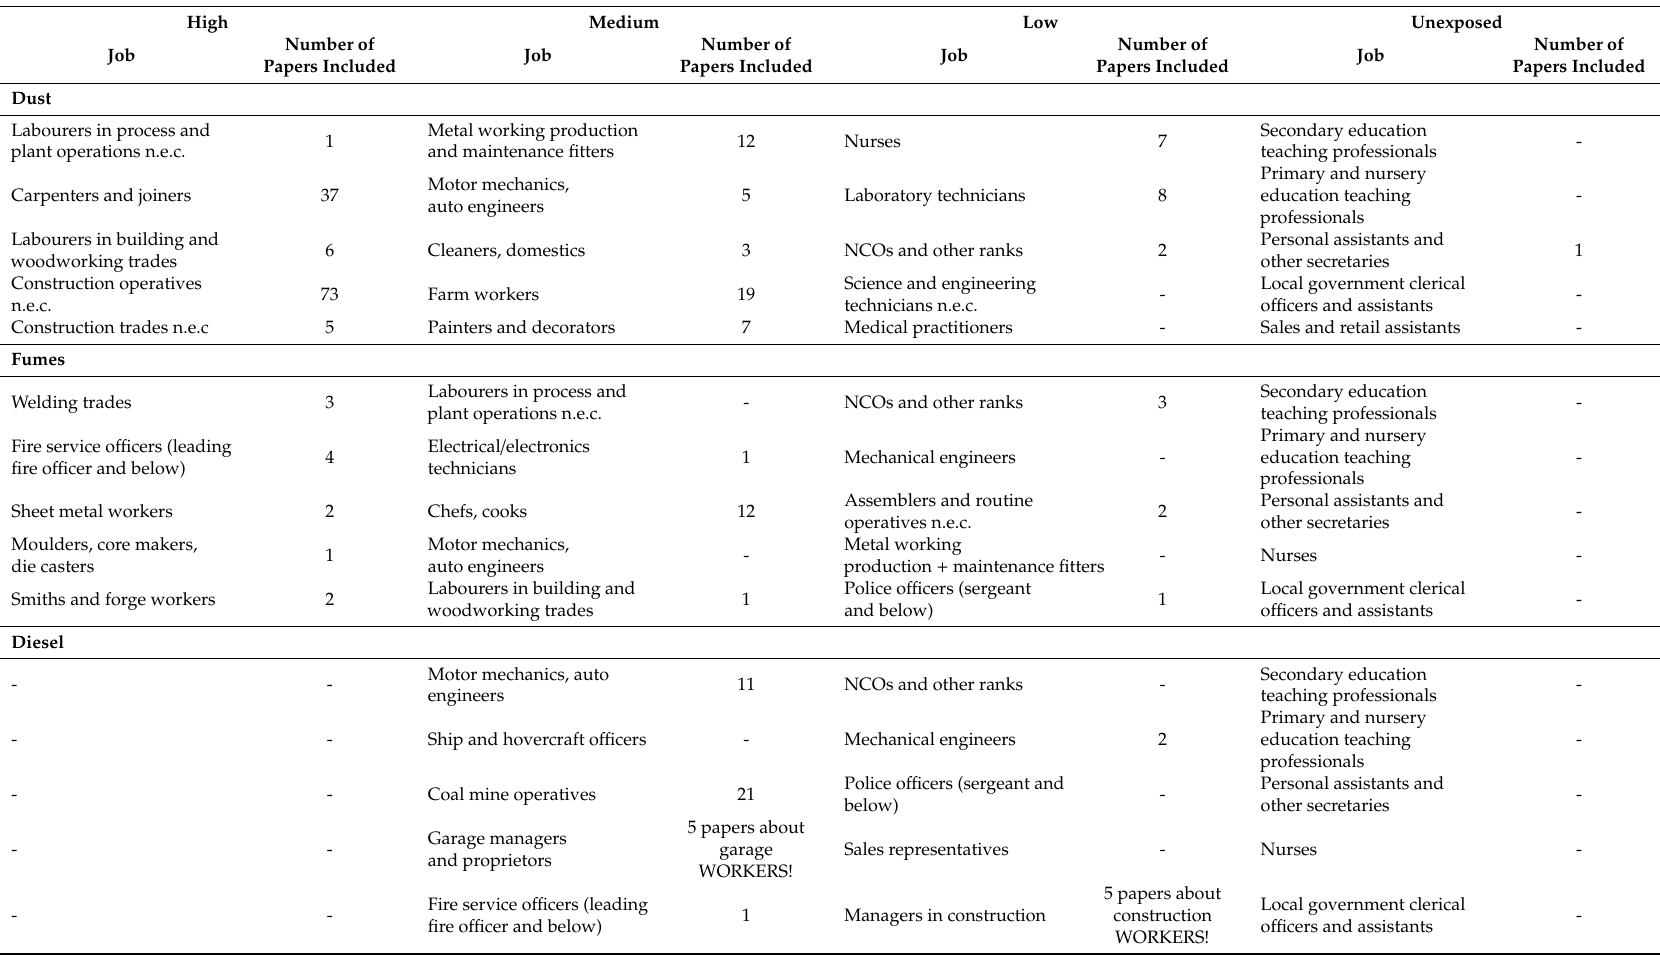
Table 6. Information gathered from the literature search for the most common occupations in UK Biobank for all the 5 agents. High Medium Low Unexposed Number of Number of Job Job Job Papers Included Papers Included